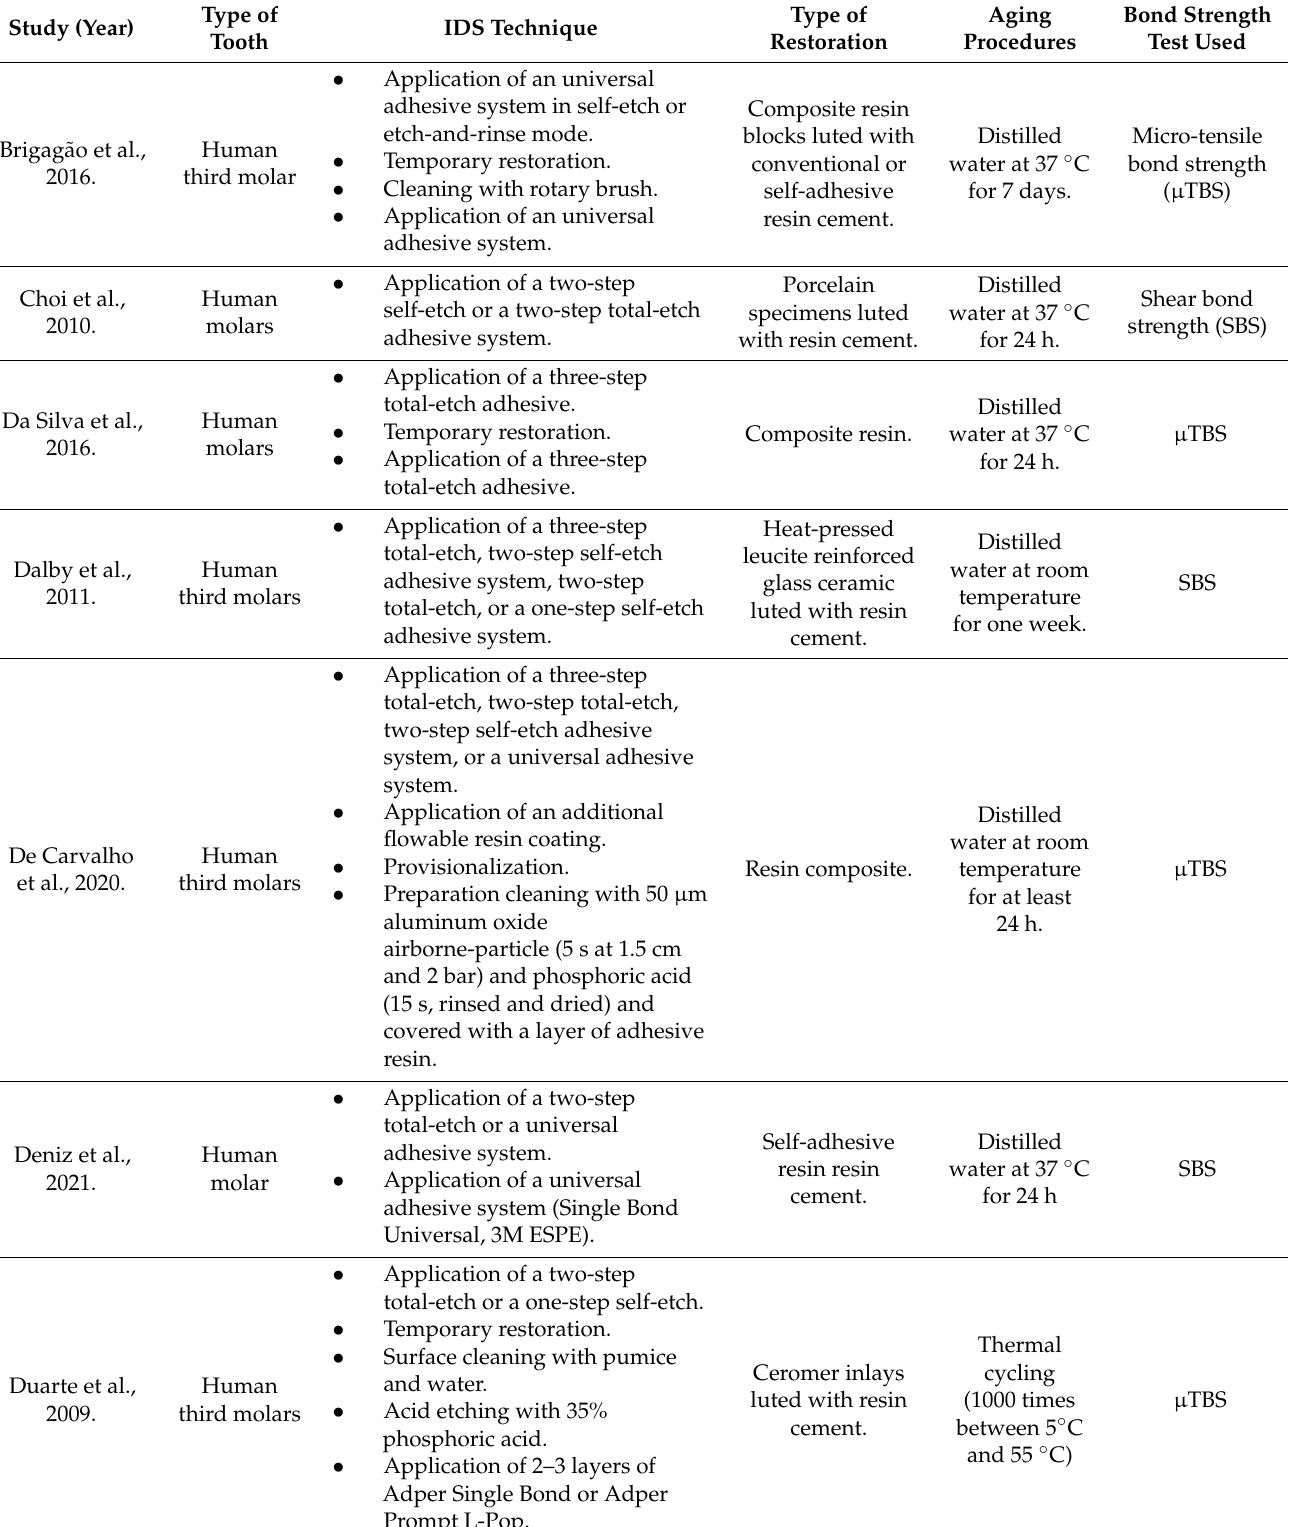
Table 1. Main characteristics of the in vitro studies included in the